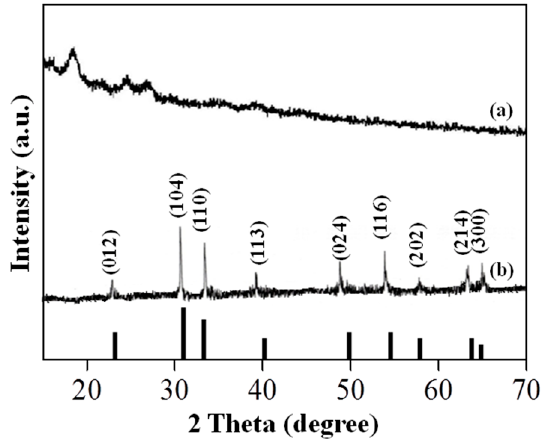
Figure 2. X-ray diffraction (XRD) patterns of the ( a ) RS and ( b ) Sp-HNP, indexed to the rhombohedral structure of hematite JCPDS card No. 33-0664 (vertical lines).